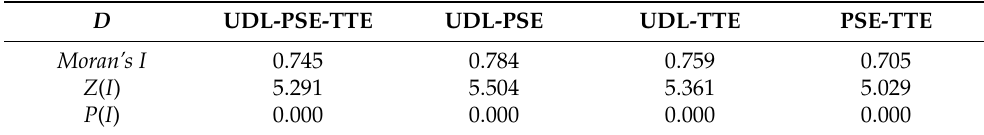
Table 5. Global autocorrelation of coupling coordination degree. D